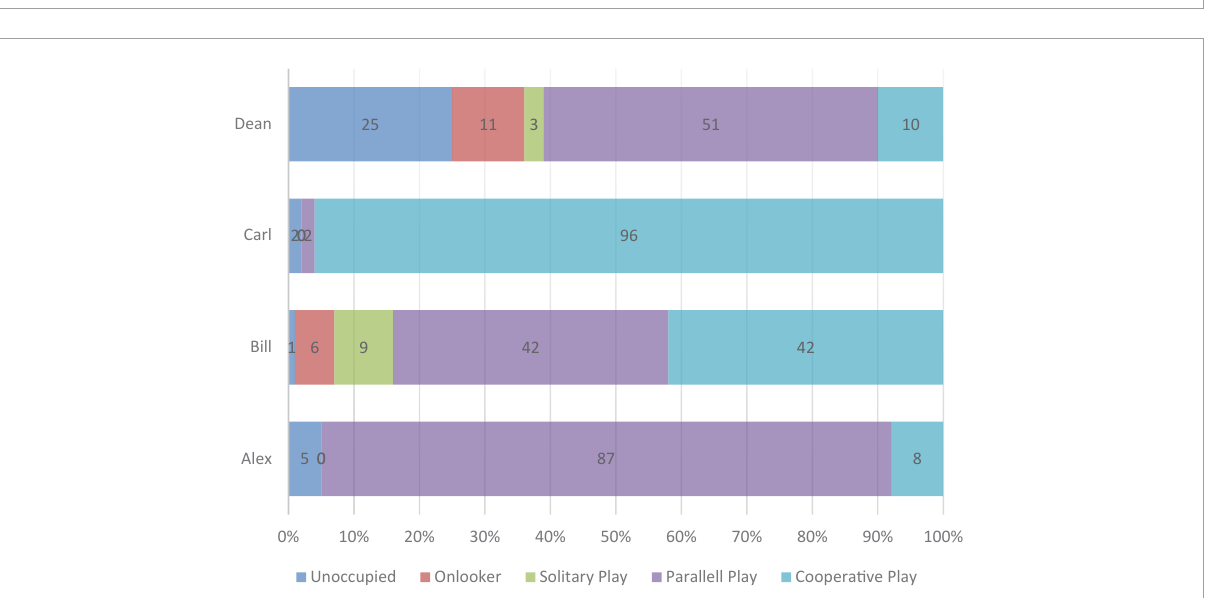
FIGURE2 Distribution of play behaviors (%) for children with SEN during 12 video-recorded PT/ST playgroups with peers (15 min/child), observed with OSPiP. For Alex playgroup 5, 7, 9; for Bill playgroup 4, 10, 11; for Carl playgroup 5, 7, 11; and for Dean playgroup 3, 4, 9; PT/ST = play/time social/time (Odom et al., 1997); SEN = Special Educational Needs; OSPiP = Observation of Social Participation in Play (Allodi Westling et al.,